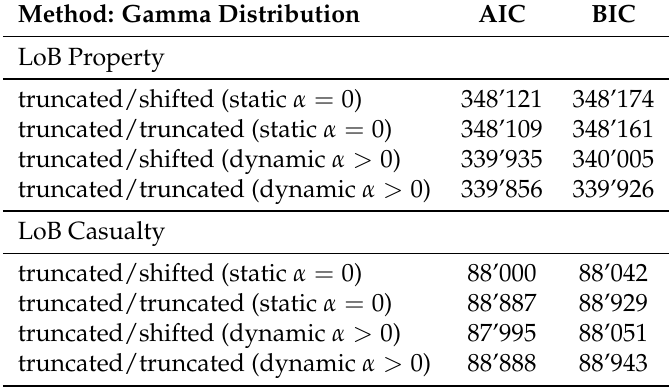
Table 7. AIC and BIC as Table 5 (top) but with log-normal distributions replaced by gamma